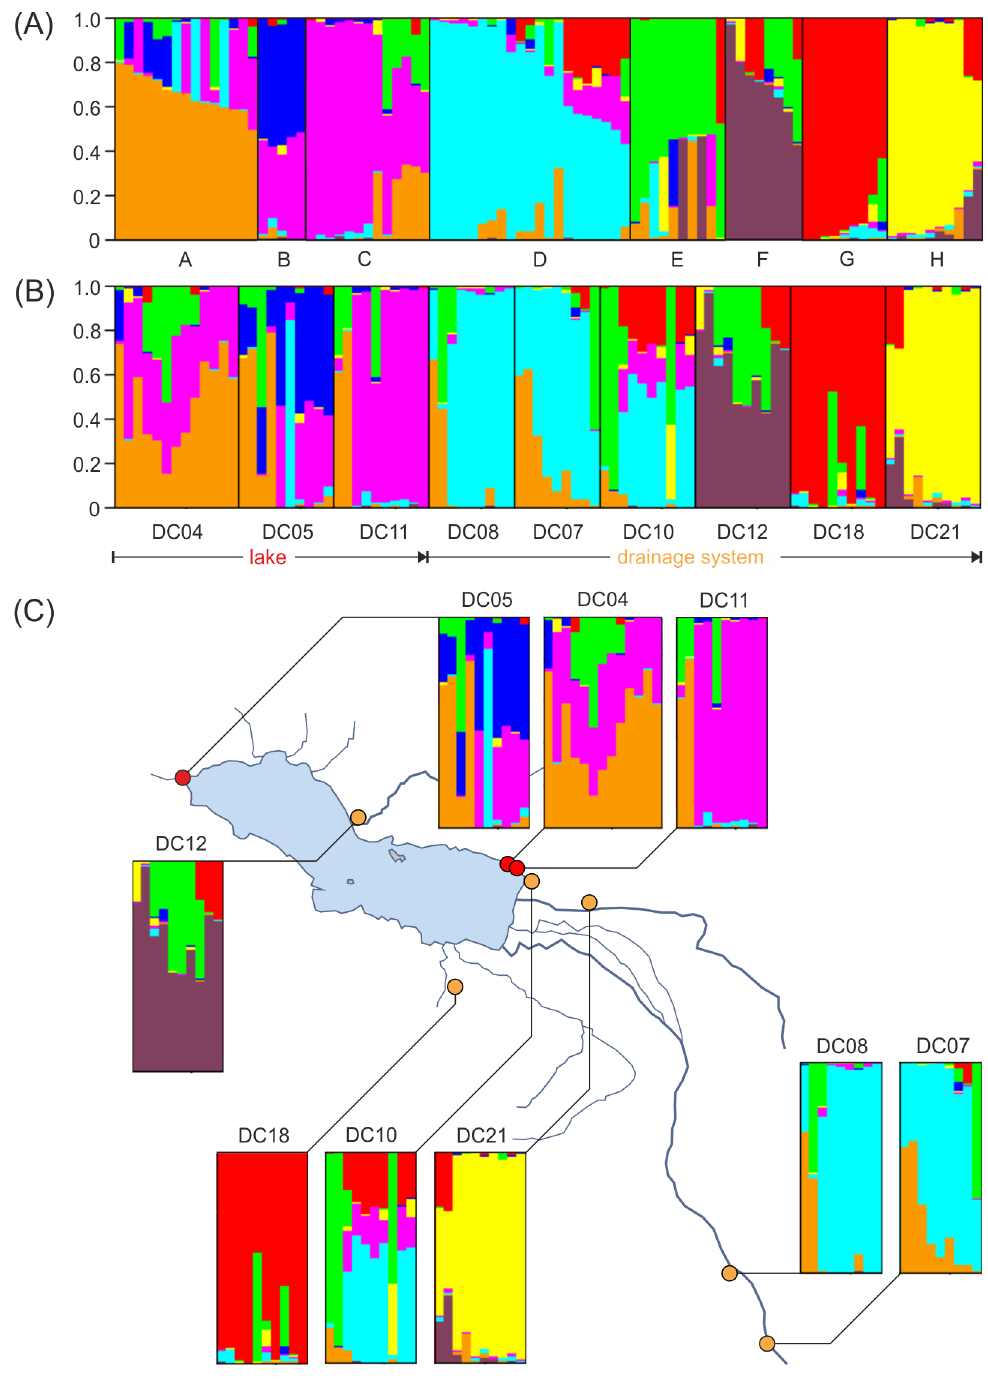
Fig 4. STRUCTURE output (K = 8) for Lake Donggi Cona Radix specimens based on AFLP data. Each group assignment is represented by a colored horizontal bar. (A) Accessions ordered according to their cluster membership (K = 8: A – H). (B) Accessions ordered according to their sampling site (lake: DC04, 05, 11; drainage system: DC07, 08, 10, 12, 18, 21). (C) Geographical presentation of the structure results. Red circles: sampling sites within the lake, orange circles: sampling sites within the drainage system. Lake map redrawn from Dietze et al. [21].